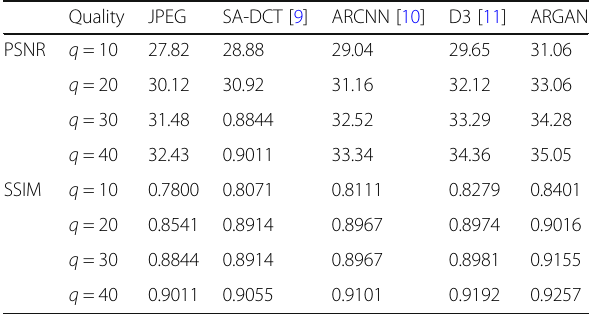
Table 4 The average results of PSNR (dB), SSIM on the five test images [9] Quality JPEG